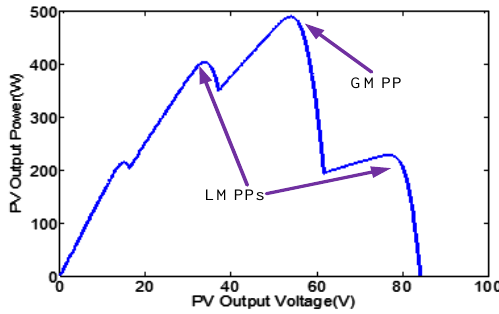
Figure 4. P-V curves in many shading conditions.